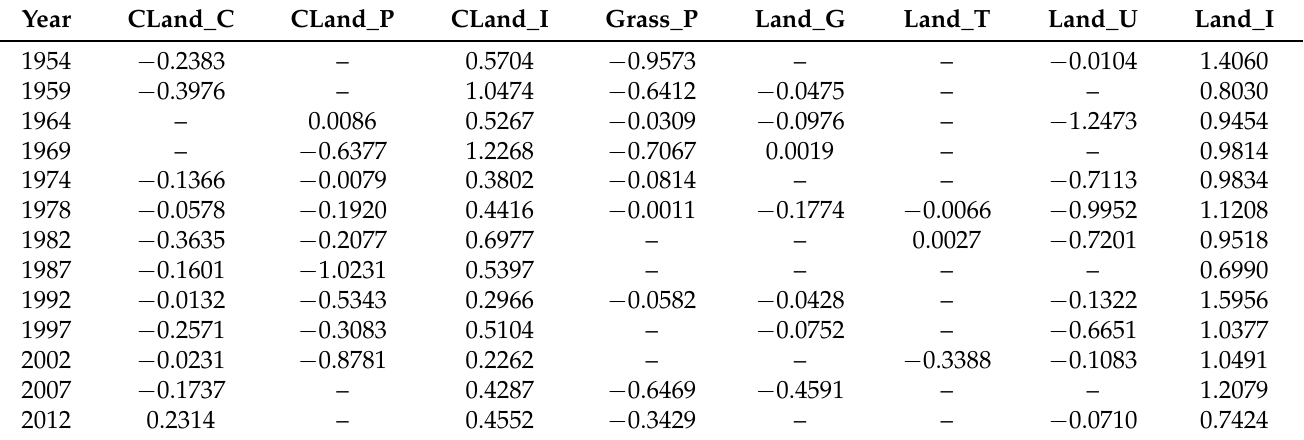
Table A2. Parameter estimates using penalty estimates via LASSO under a spatial logistic